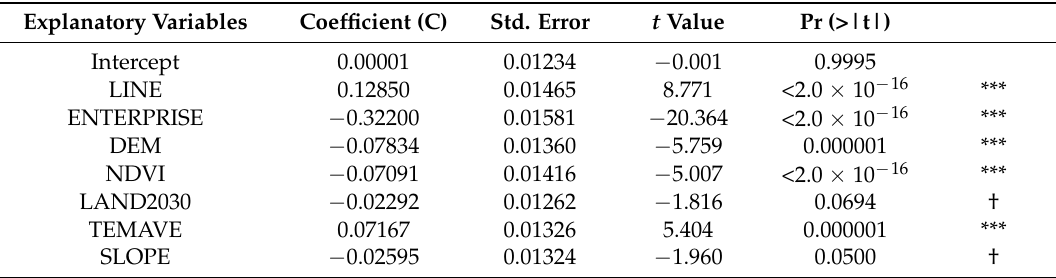
Table 4. Statistical summary of the LM.